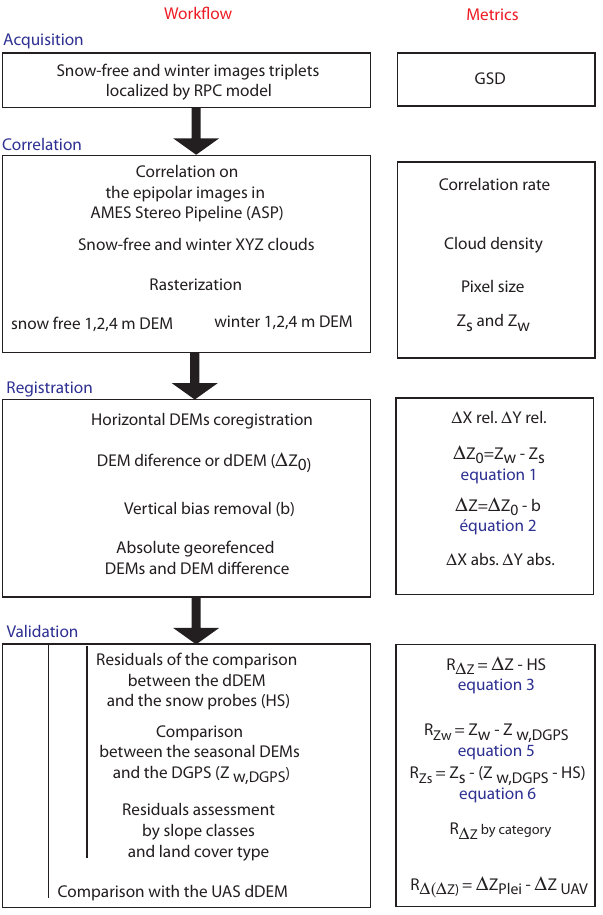
Figure 3. Successive phases in Pléiades triplets processing and as- sociated metrics of